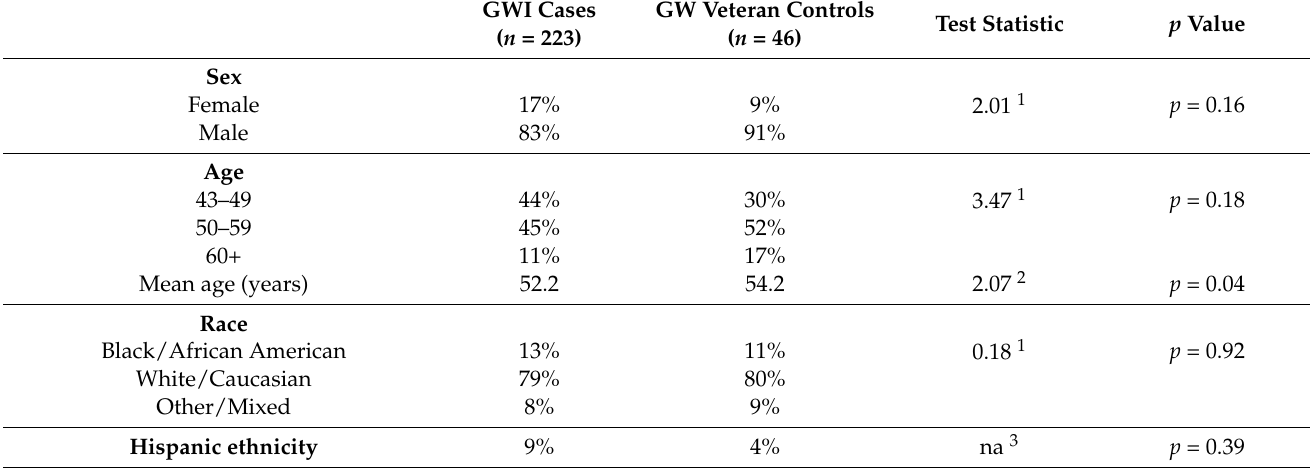
Table 1. Demographic, military, and deployment characteristics of GWI cases and